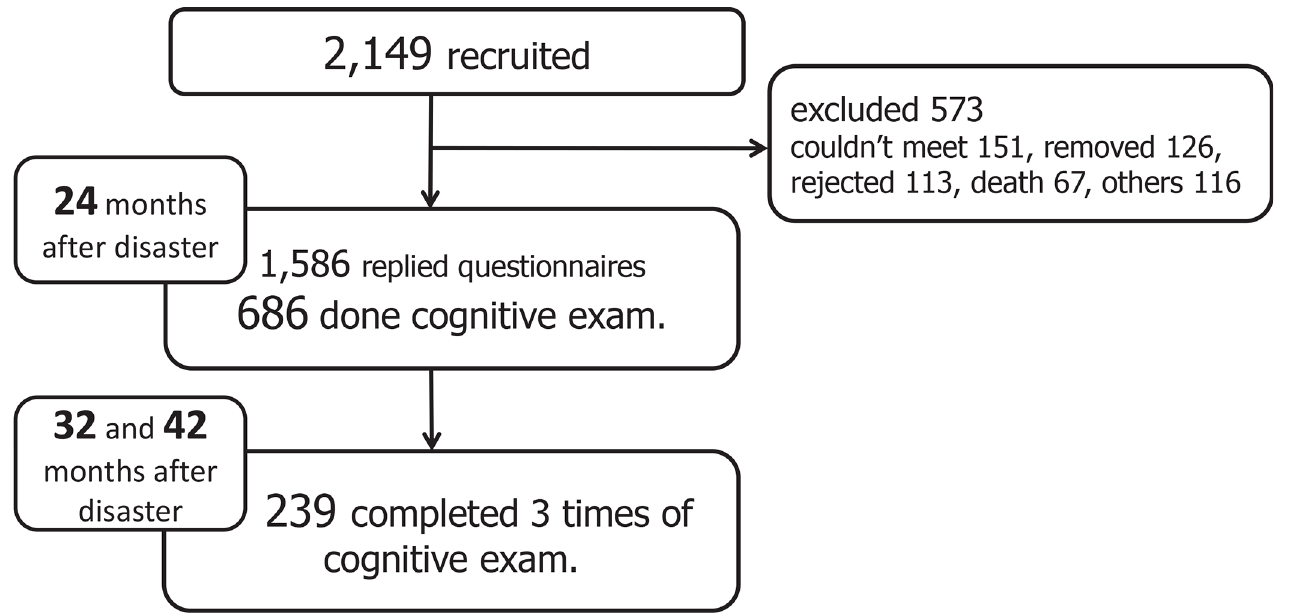
Fig 1. Schema of study design, sample selection, and study